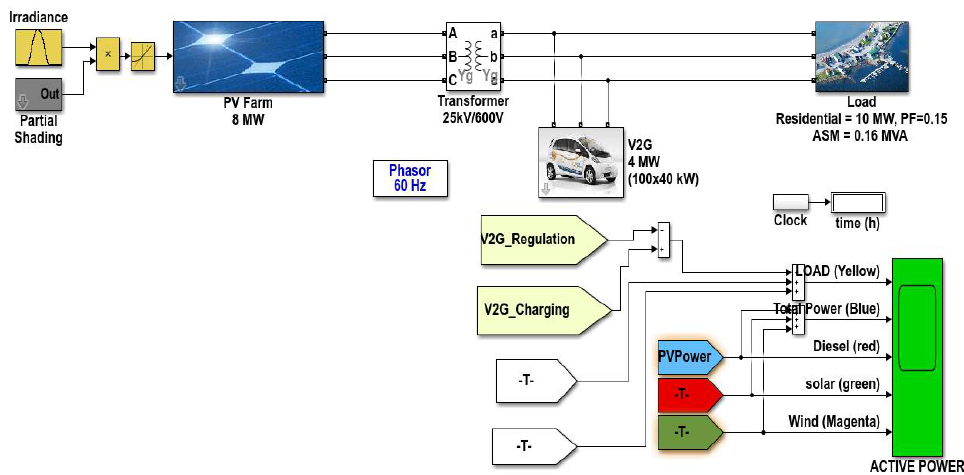
Figure 6. Simulink model for overall analysis.